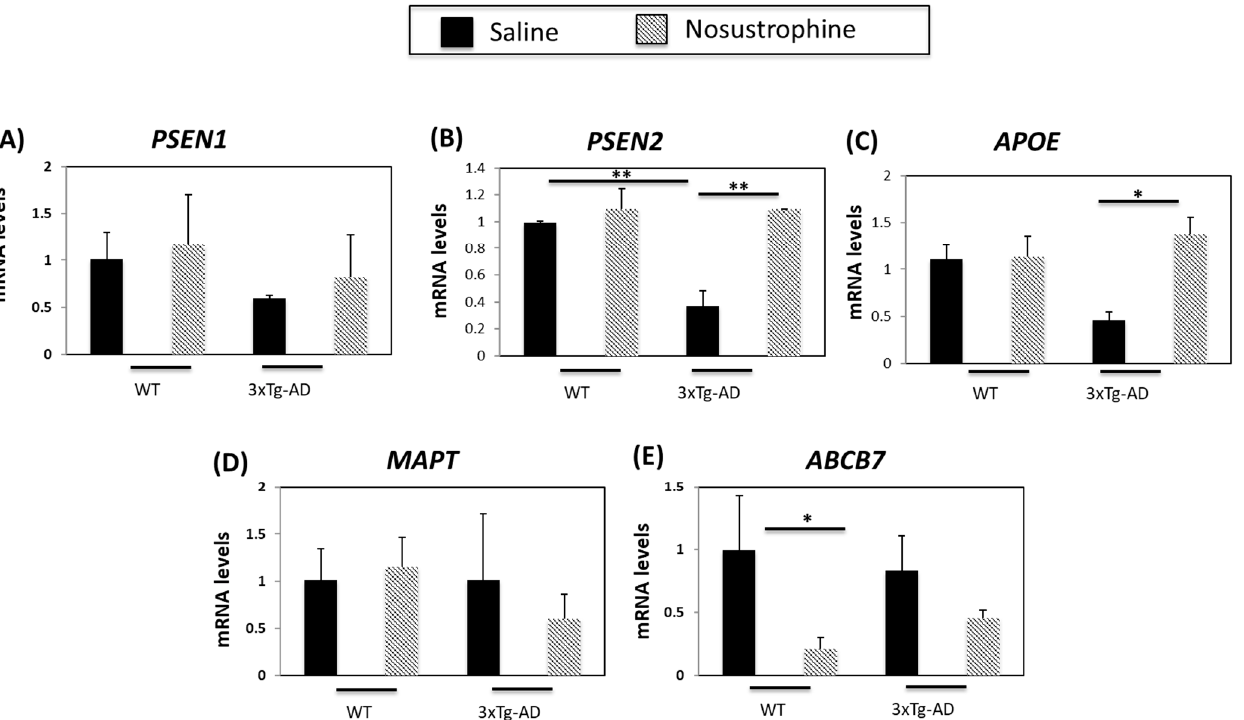
Figure 4. Nosustrophine regulates AD-related gene expression in young (3–4-month-old) mice. PSEN1 ( A ), PSEN2 ( B ), APOE ( C ), MAPT ( D ) and ABCB7 ( E ) mRNA levels were measured by qPCR in the hippocampus of wild-type and 3xTg-AD mice. ( n = 4 in each group) Results are expressed as fold induction versus saline-treated wild-type- or trigenic mice. Data are expressed as means ± S.E.M. * p < 0.05, ** p < 0.01.